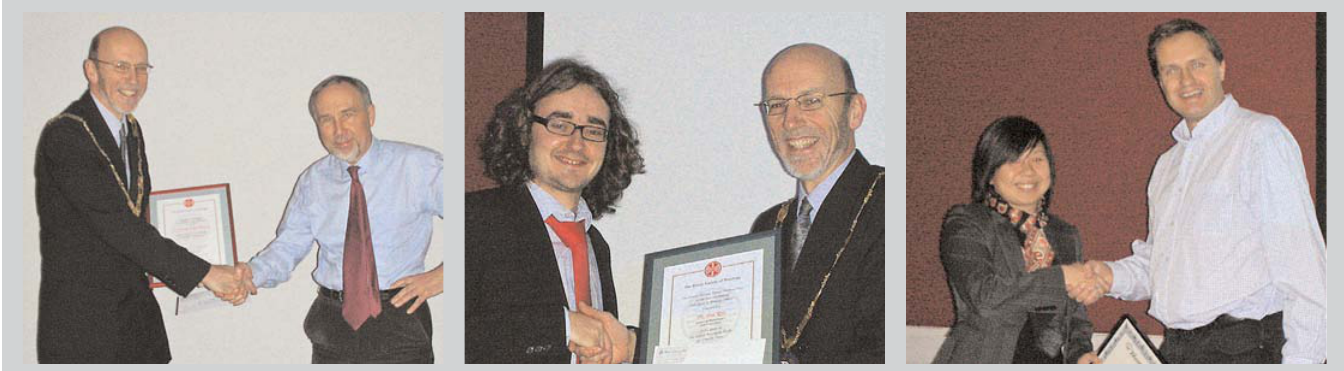
Figure 1 (left): Gerry Meeten (Schlum- berger) accepts the BSR Annual Award from Presi- dent Phil Banfill. Figure 2 (middle): Tim Reis (UCL) receives the Vernon Harrison prize from BSR president Phil Banfill. Figure 3 (right): Line Do (Nottingham) accepts the Rheometric award for best poster from TA’s Peter